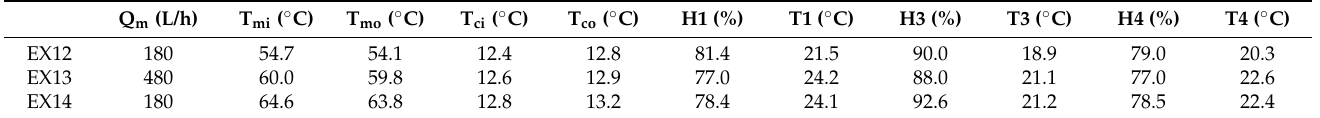
Table 6. Measured temperatures and humidity for MM003.